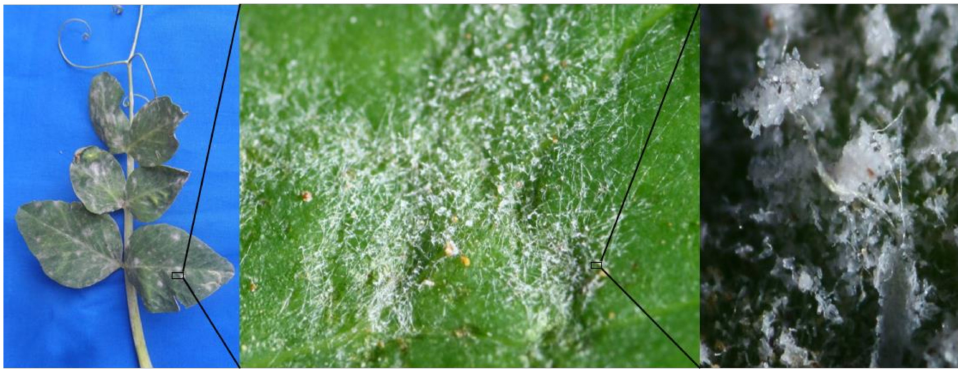
Figure 1. Powdery mildew symptoms showing aerial mycelium and conidia on pea